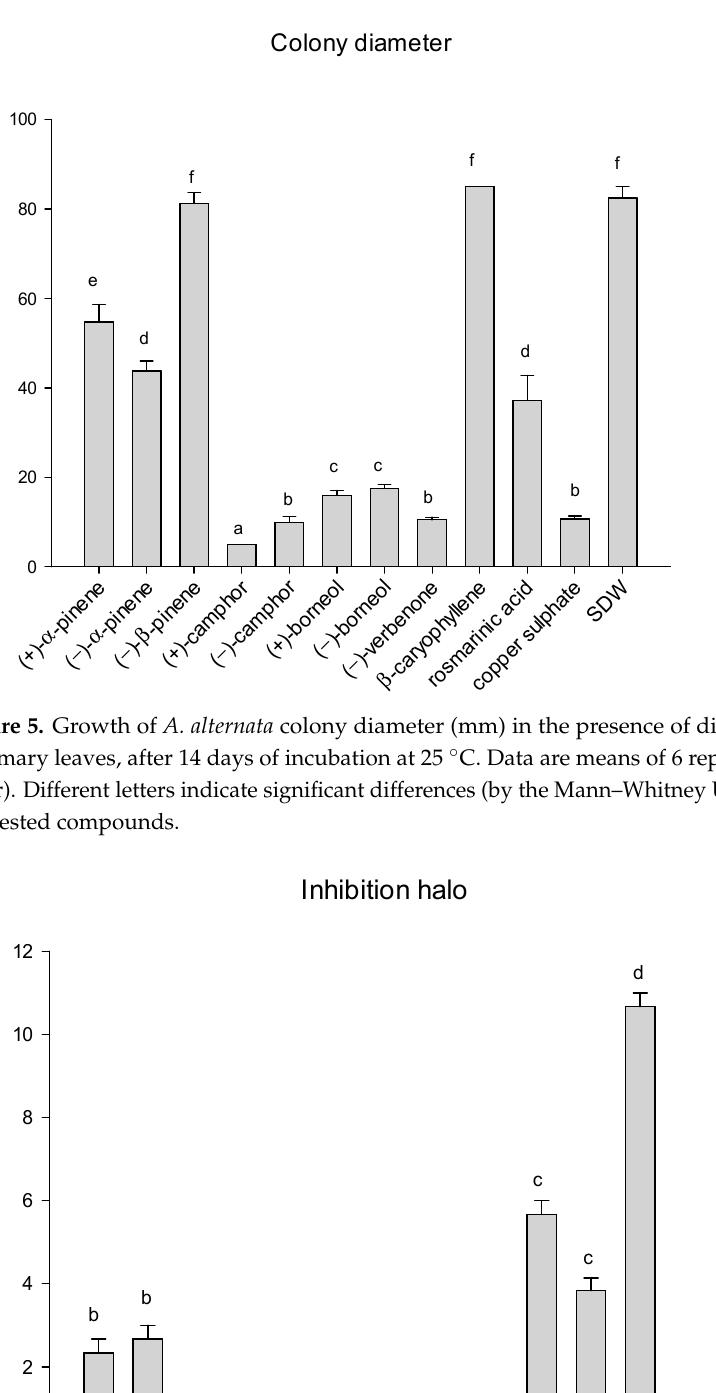
Figure 6. Size of inhibition halo (mm) determined by different compounds of rosemary leaves against the bacterium P. viridiflava , after 48 h of incubation at 27 °C. Data are means of 6 replicates + SE (standard error). Different letters indicate significant differences (by the Mann–Whitney U-test, p < 0.05) among the tested compounds.